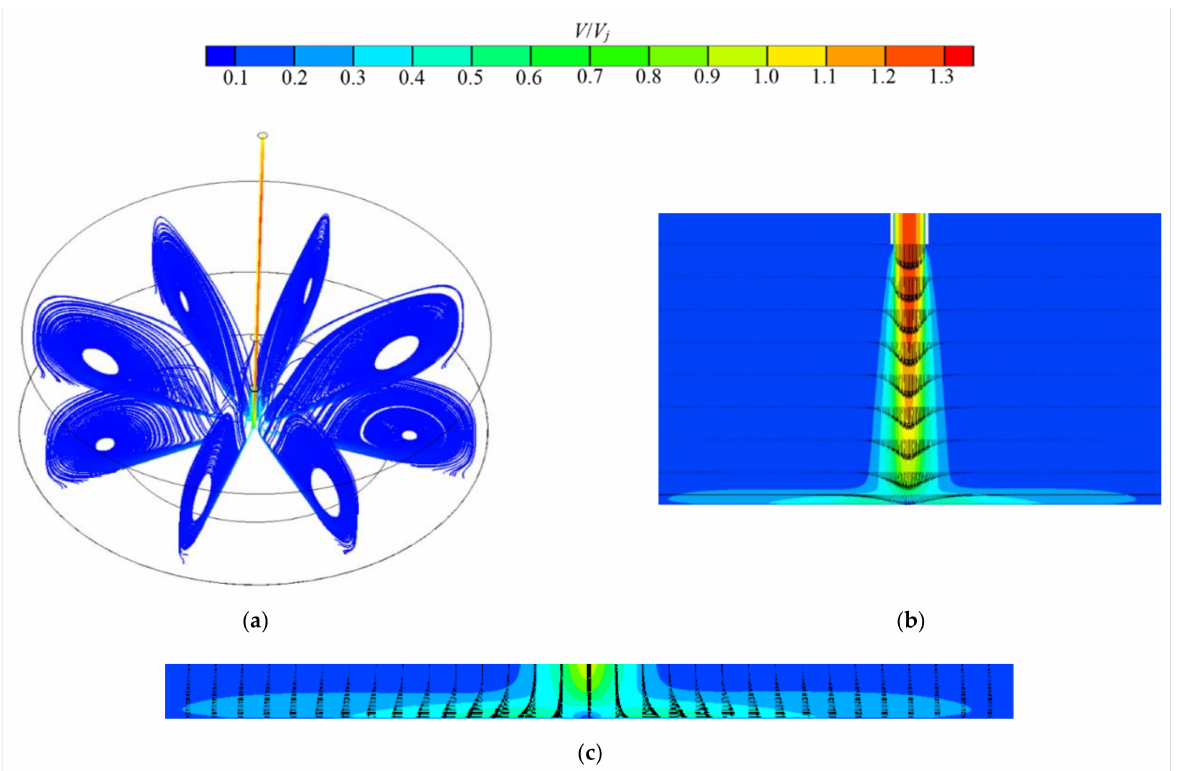
Figure 8. The flow structure of a continuous jet impacting a stationary wall: ( a ) full flow field; ( b ) cross-section of flow field; ( c ) near